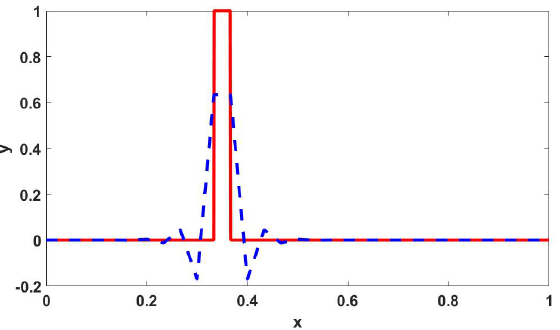
Figure 3. Solid red: A discontinuous function. Dashed blue : The projection onto a finite element space with linear Lagrangian